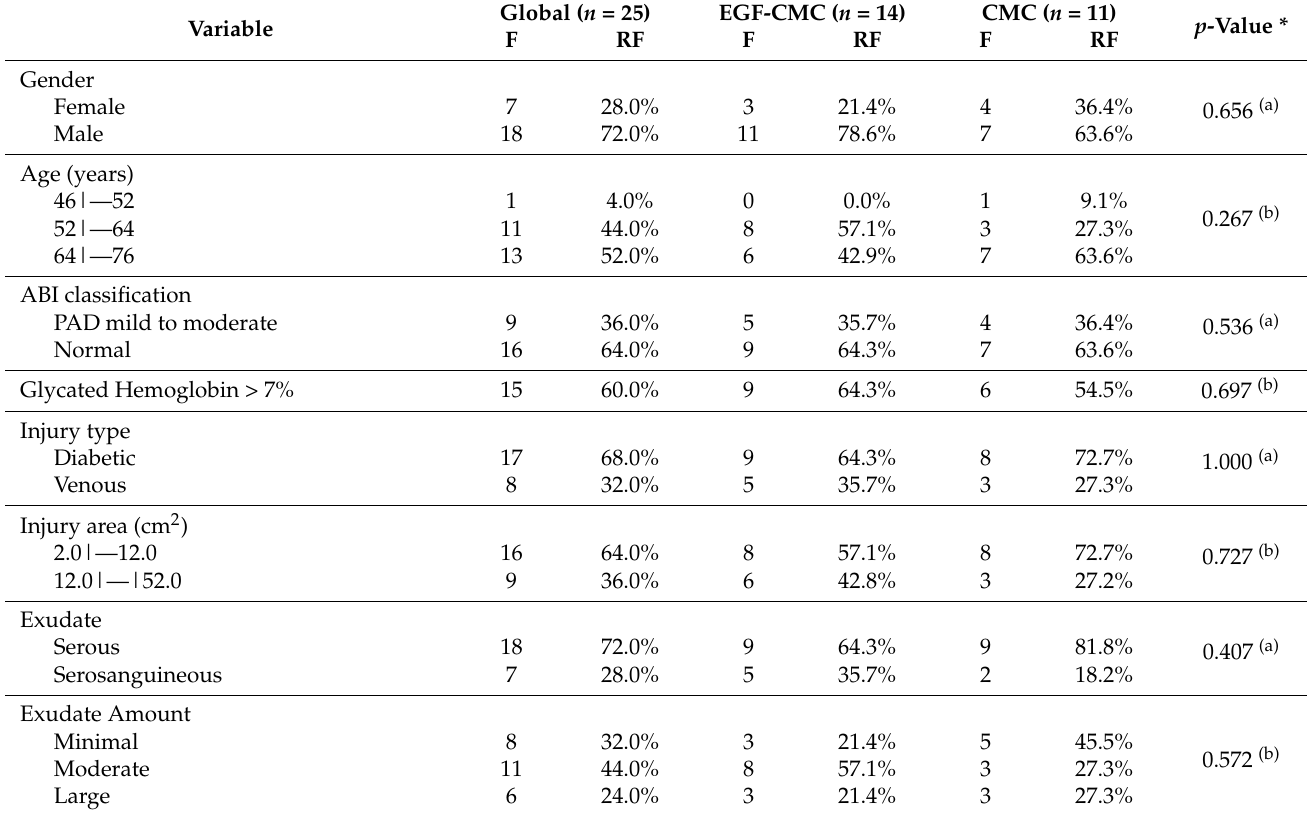
Table 1. Initial characteristics of the wounds and the health history of the